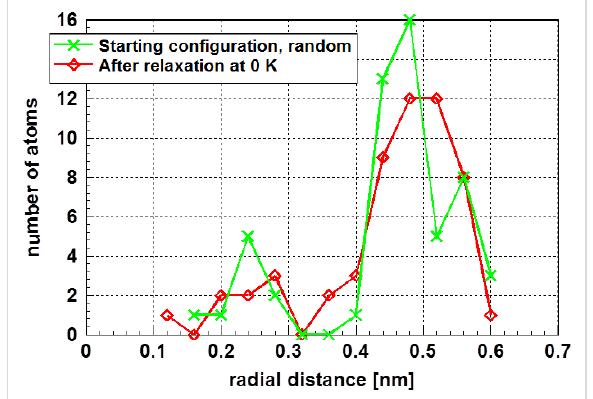
Figure 2: Radial distribution function of gold atoms in the amorphous cluster determined by averaging the number of atoms along a dis- tance (bin) of 2 × 10 − 2 nm. The random starting situation and the annealed crystalline structure, both relaxed at 0 K, are shown. The relaxed cluster is composed of two layers around a central atom.